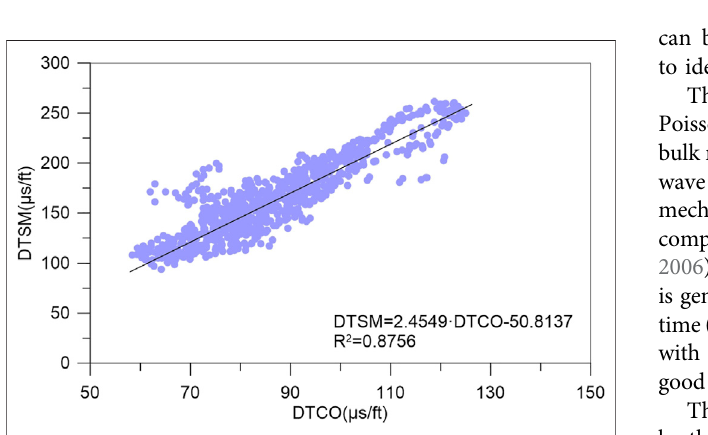
Frontiers in Earth Science |